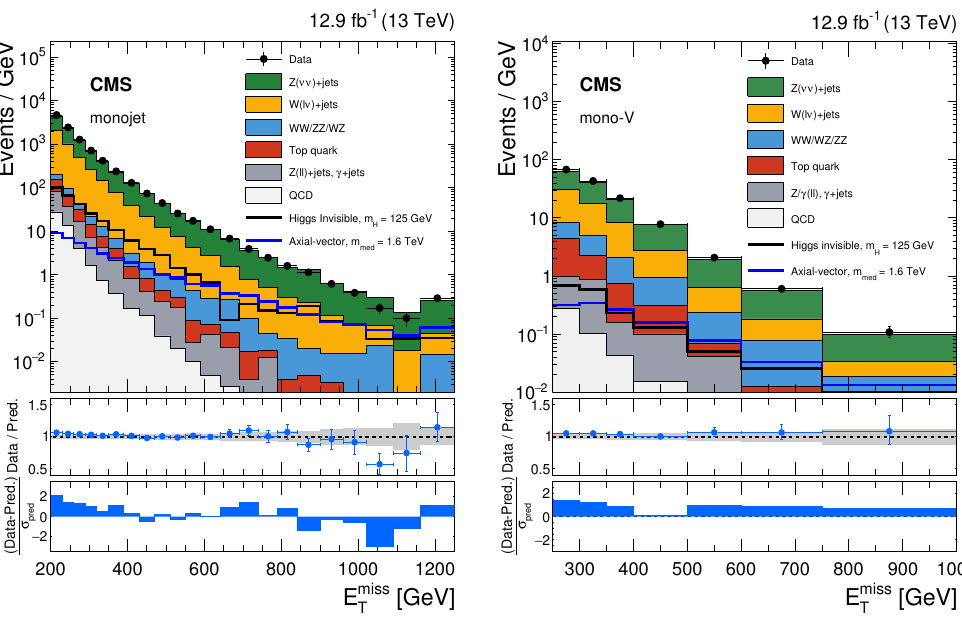
Figure 6 . Observed E miss distribution in the monojet (left) and mono-V (right) signal regions T compared with the background expectations for various SM processes evaluated after performing a combined (cid:12)t to the data in all the control samples, but excluding the signal region. The last bin includes all events with E miss > 1160 (750) GeV for the monojet (mono-V) category. Expected signal T distributions for a 125 GeV Higgs boson decaying exclusively to invisible particles, and for a 1.6 TeV axial-vector mediator decaying to 1 GeV DM particles, are overlaid. The ratio of data and the post-(cid:12)t background prediction is shown for both the monojet and mono-V signal regions. The gray bands in these ratio plots indicate the post-(cid:12)t uncertainty in the background prediction. Finally, the distributions of the pulls, de(cid:12)ned as the di(cid:11)erence between data and the post-(cid:12)t background prediction relative to the post-(cid:12)t uncertainty in the prediction, are also shown in the lower panels.